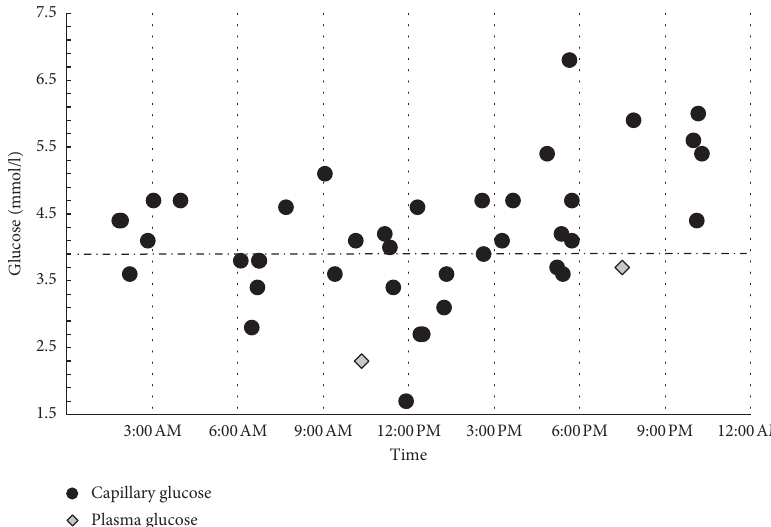
Figure 1: Capillary and plasma glucose values that were recorded during 7 days of hospitalization. All values are projected to a 24-hours view. These values were recorded on the first presentation at hospital admission. The dashed line marks the cutoff value for hypoglycemia with 3.9mmol/l.